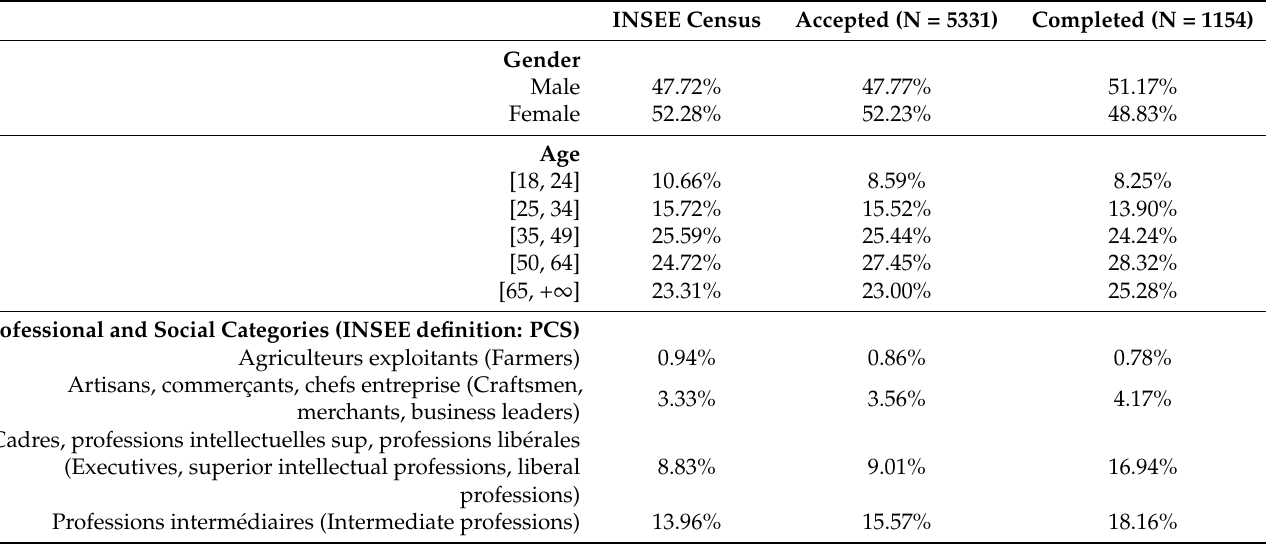
Table 1. Representativeness of the